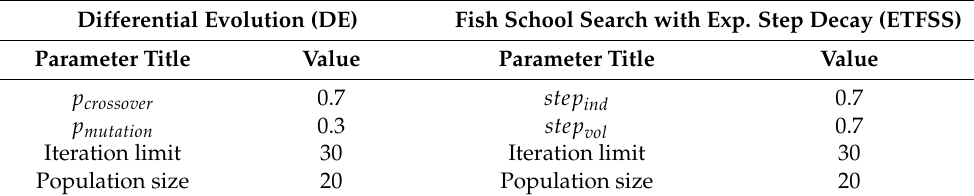
Table 6. Parameters of the considered biology-inspired algorithms.